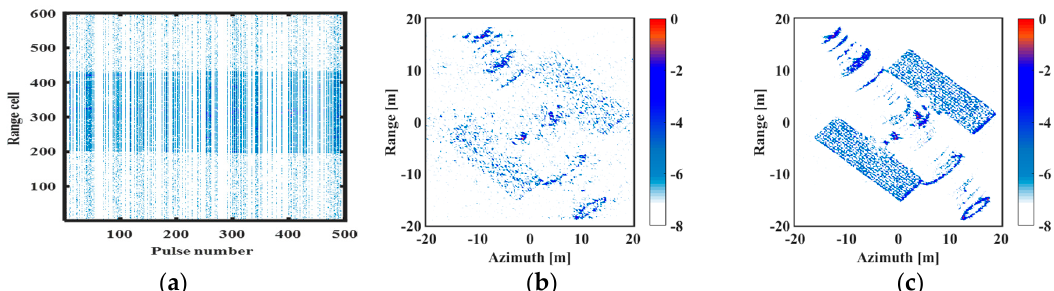
Figure 14. Range profiles and imaging results with RMS of 150 pulses: ( a ) Range profiles; ( b ) Imaging result of algorithm in [23]; ( c ) Imaging result of the proposed algorithm.